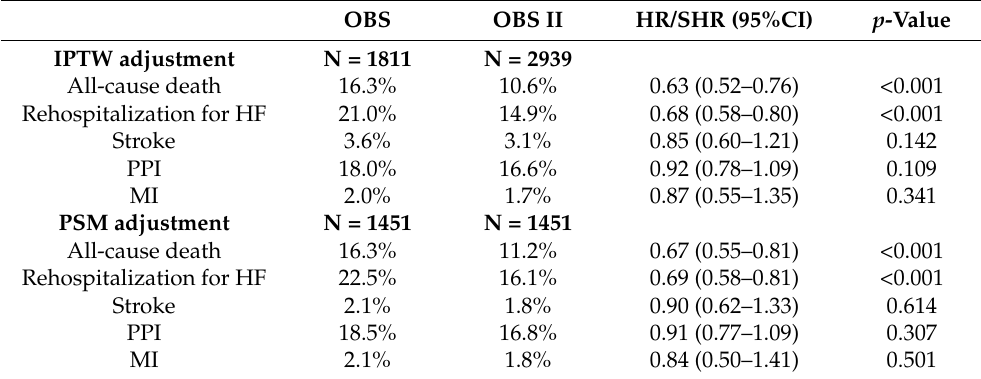
Table 2. One-year outcomes after inverse probability of treatment weighting (IPTW) and propensity score matching (PSM)